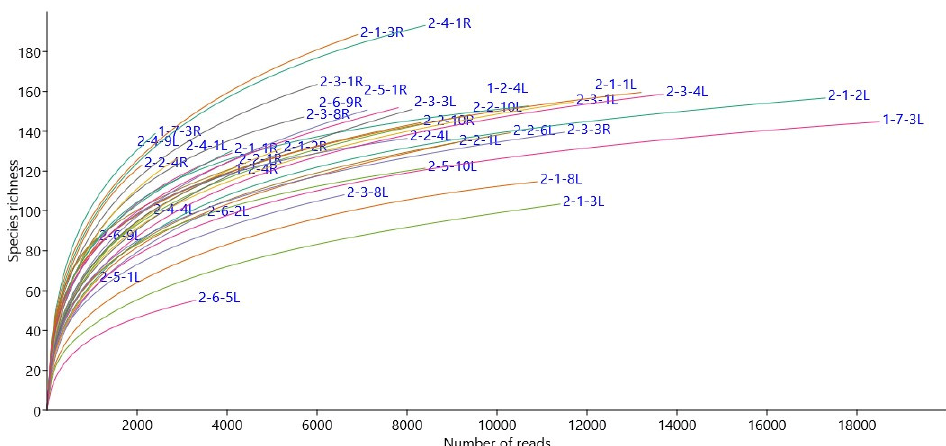
Figure 1. Rarefaction curves for each sample for endophytic fungal community data in meadow fescue ( Festuca pratensis ) showing species richness to the number of reads acquired. Each curve is marked with the sample name and specific tissue (L: leaf, R: root).